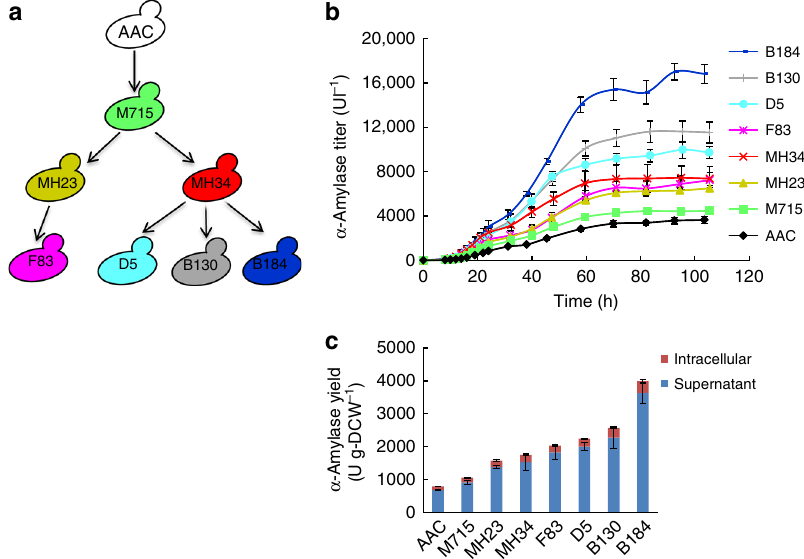
Fig. 1 α -Amylase secretion yeast strains in batch cultures. a Evolutionary relationships among the strains used in this study. Strains were selected for higher α -amylase production from ultraviolet mutagenesis libraries with micro fl uidic screening in an earlier study 16 . b α -Amylase titer of strains during batch cultures. Cells were cultured with an initial OD 600 of 0.01 in SD- × SCAA medium in a bioreactor by controlled at 30 °C, 600rpm agitation, 30 l h − 1 air fl ow, pH = 6. c The fi nal α -amylase yield. Data shown are mean values ± standard deviations of triplicates or